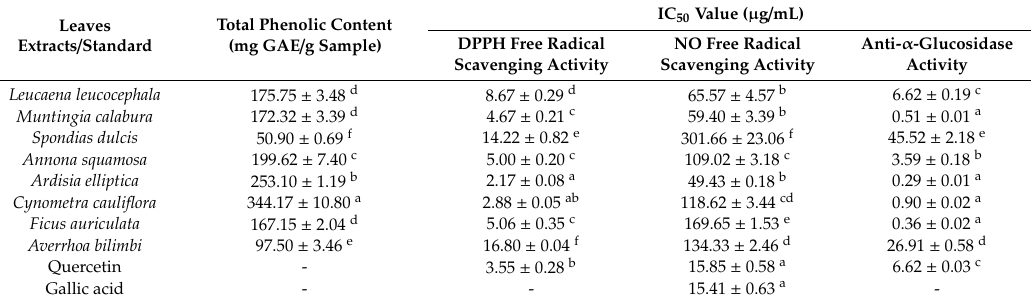
Table 1. Total phenolic content (TPC), 2,2-diphenyl-1-picrylhydrazyl (DPPH) and nitric oxide (NO) free radical scavenging, and anti- α -glucosidase activities of the extracts. IC 50 —half maximal